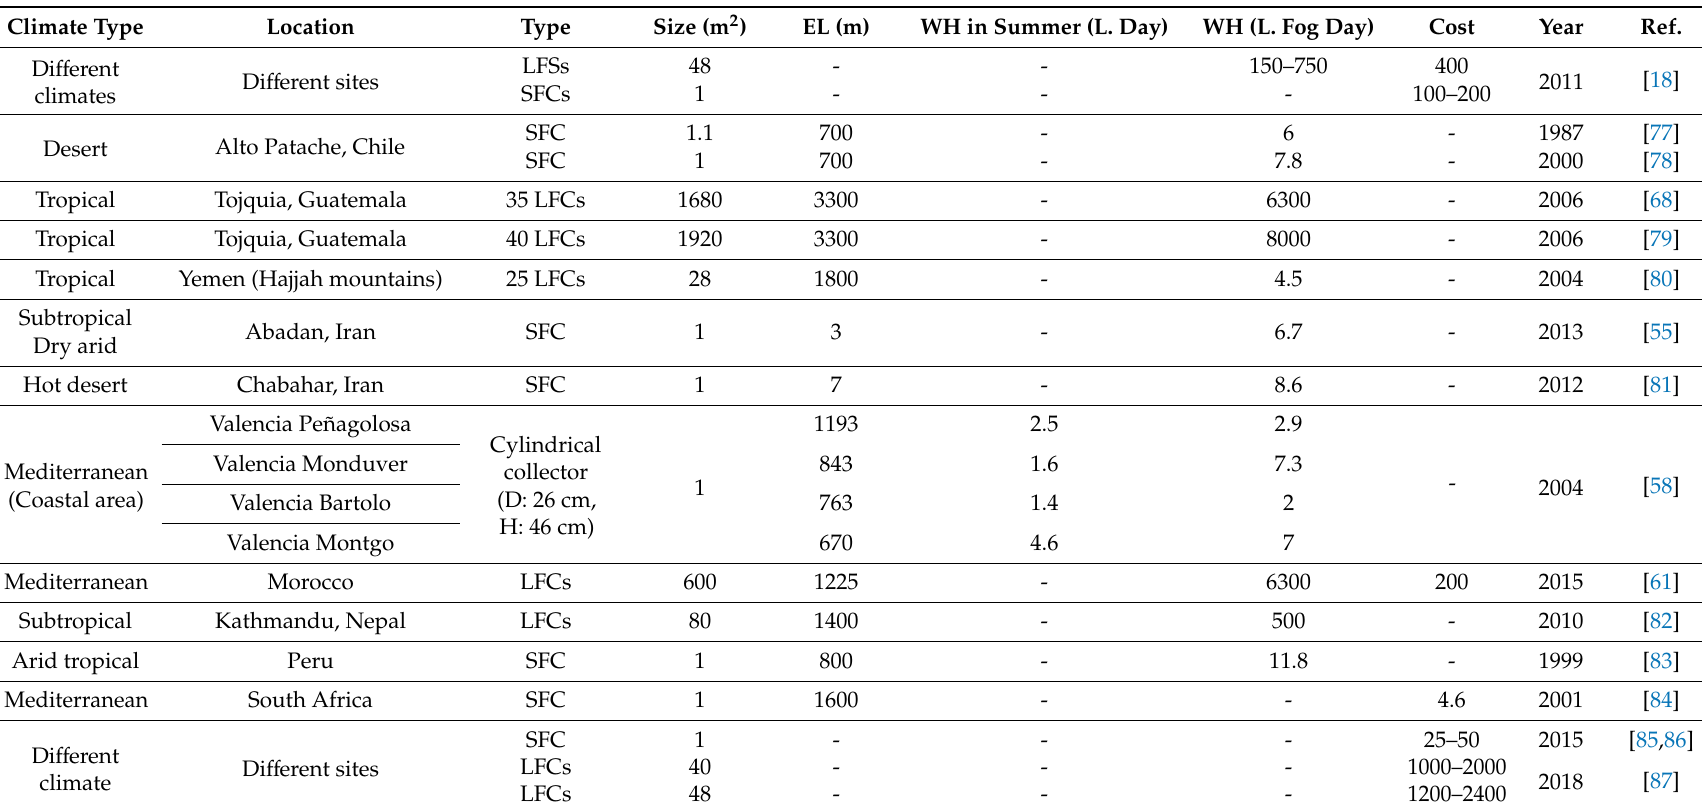
Table 1. The potential of fog water harvesting in di ff erent case studies and climate